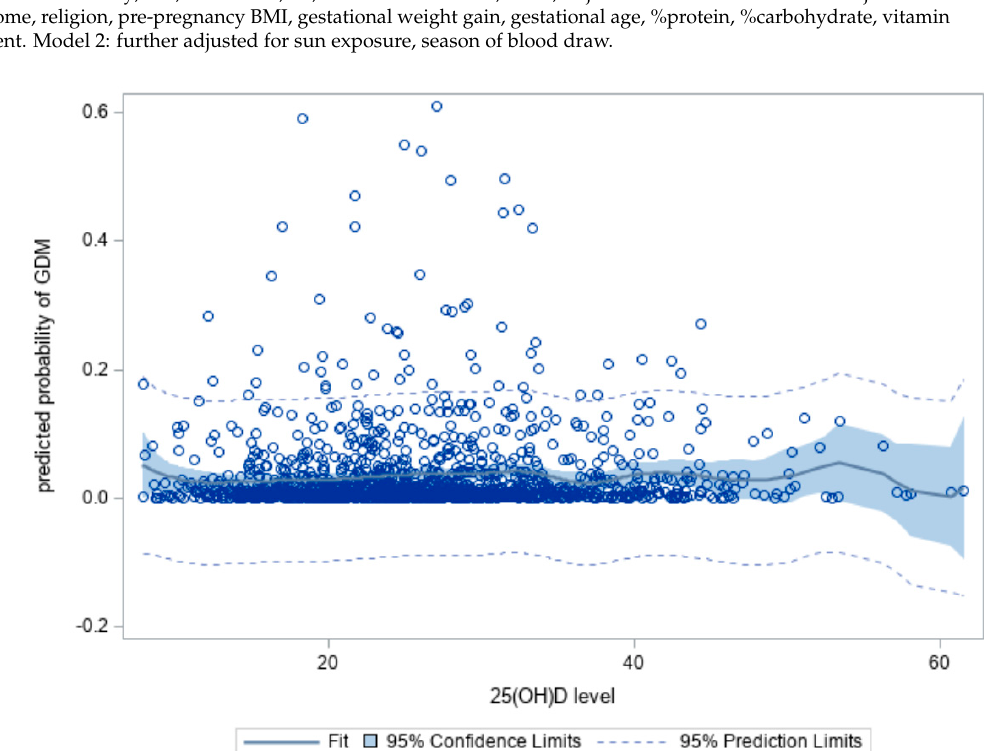
Table 3. Association between vitamin D during pregnancy and gestational diabetes mellitus.